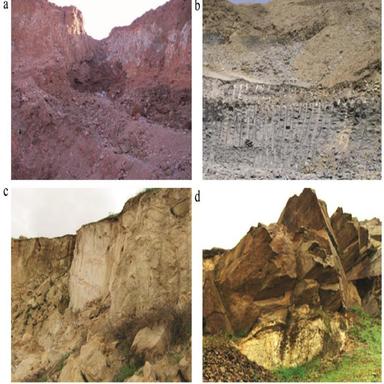
Raw material deposits: (a) Red clay of Safi; (b) Marl of Fez; (c) Kaolinitic clay of Oulmes; (d) Andalusite rich schists of Oulmes. (For interpretation of the references to color in this figure legend, the reader is referred to the web version of this article.)